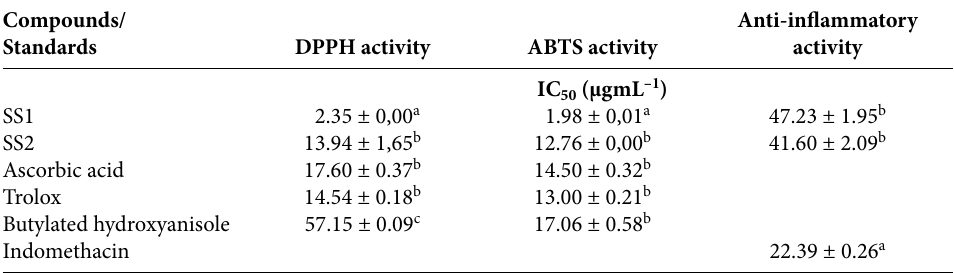
Table 3. Antioxidant and anti-inflammatory activities of compounds isolated from Stachys subnuda and standards